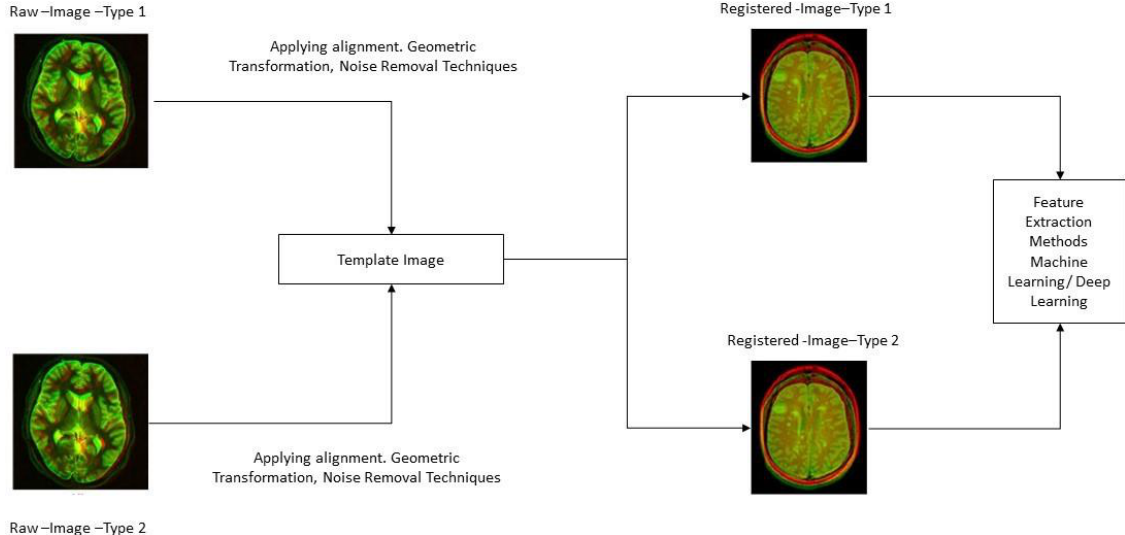
Figure 7. Before and After MRI image Registration